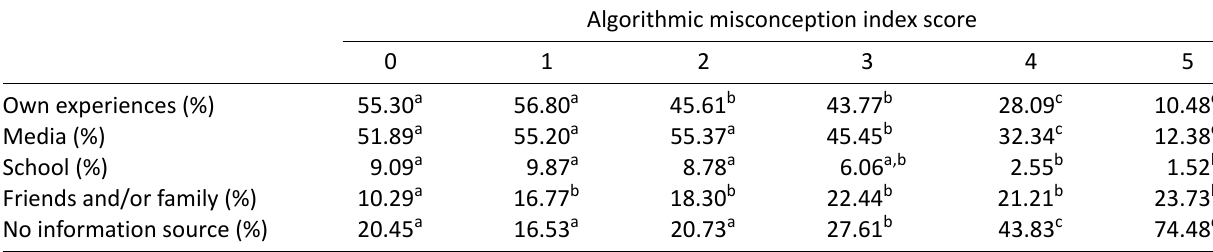
Table 3. Information sources in function of people’s algorithmic misconception index